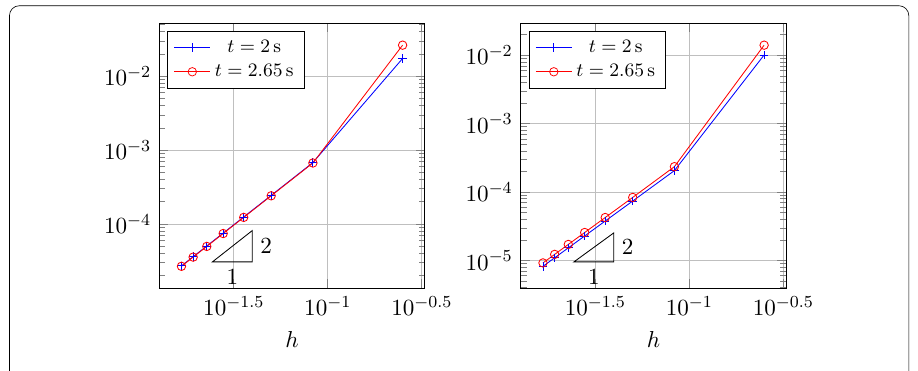
Fig. 1 Convergence of scheme (QIP) w.r.t. the space step h , for final time t = 2s, t = 2 . 65s for a homogeneous isotropic material. Left: Relative L 2 ( Ω T )-error on the displacement. Right: relative L ∞ ( L 2 ( Ω ))-error on the